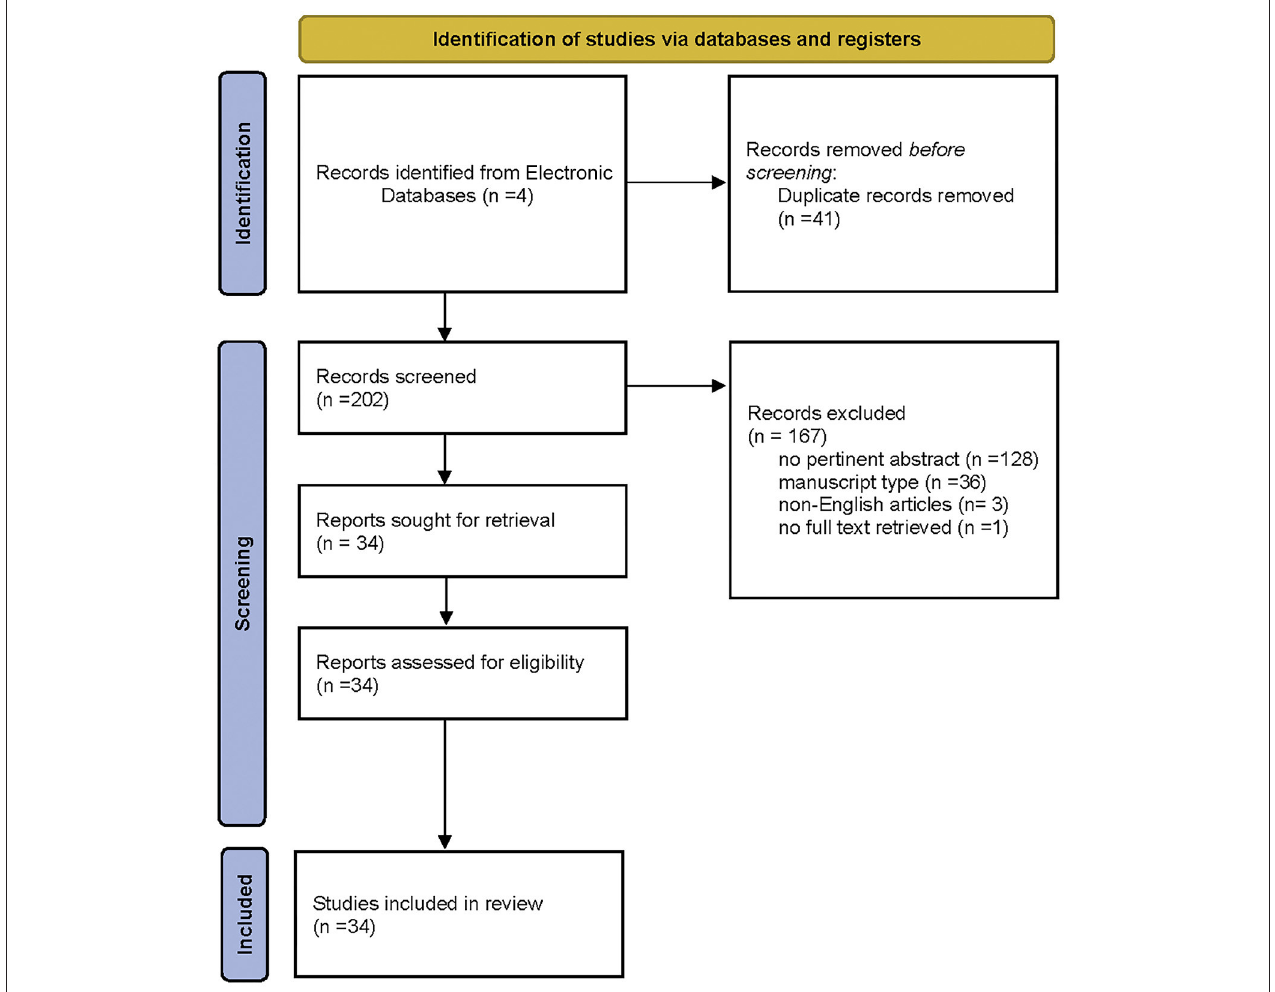
FIGURE 1 | PRISMA 2020 flow diagram for new systematic reviews which included searches of databases and registers only. From: